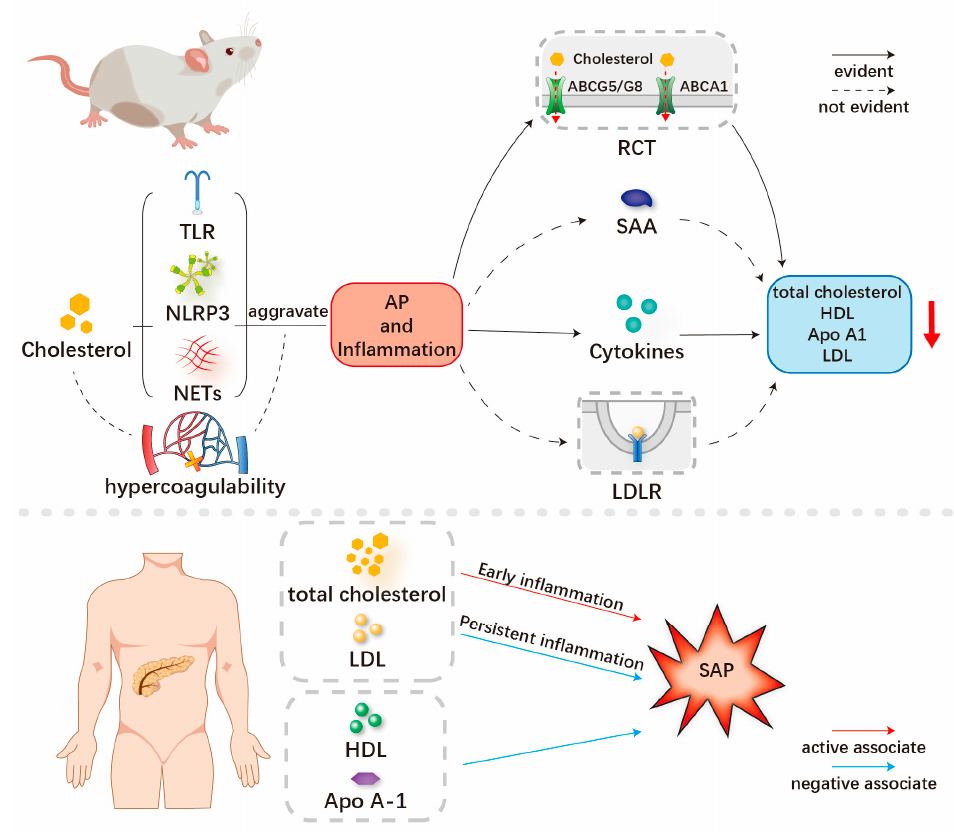
Figure 1. Overview of relationship between cholesterol-related lipids and severe acute pancreatitis.